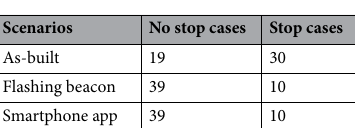
Table 1. Number of pedestrians’ stops during